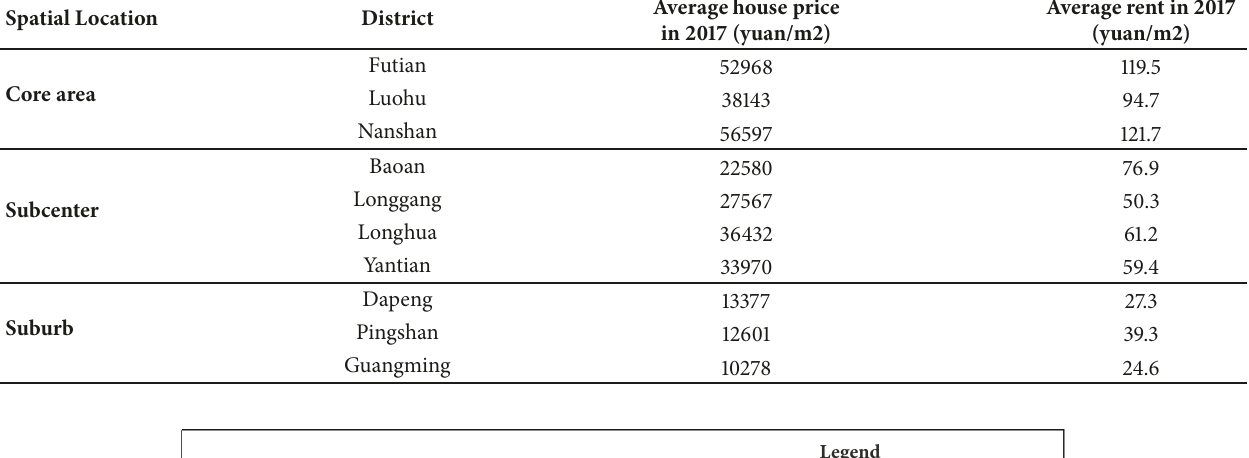
Table 1: Average house price and average rental price of ten districts in Shenzhen in 2017.